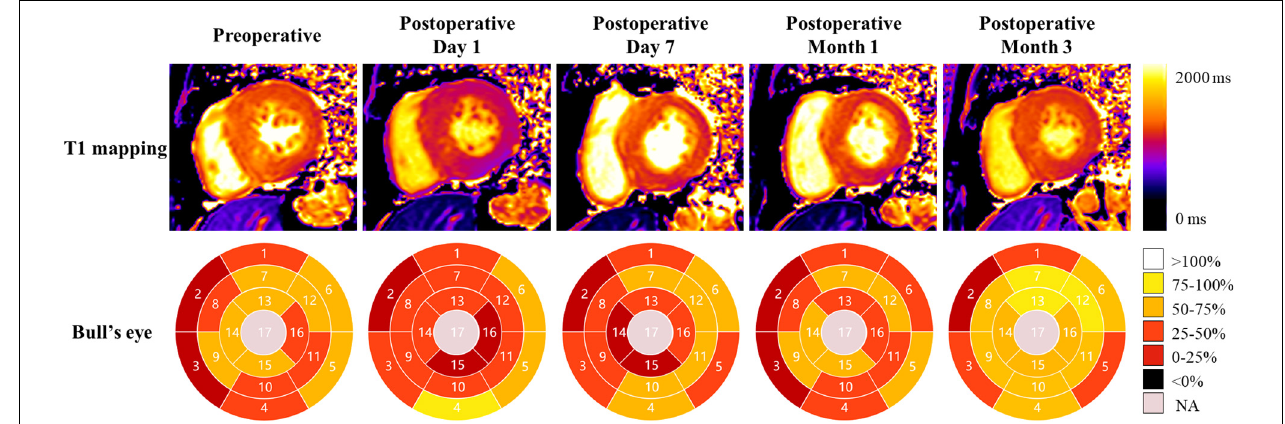
FIGURE 3 | Preoperative and postoperative magnetic resonance images of T1 mapping and bull’s eye.